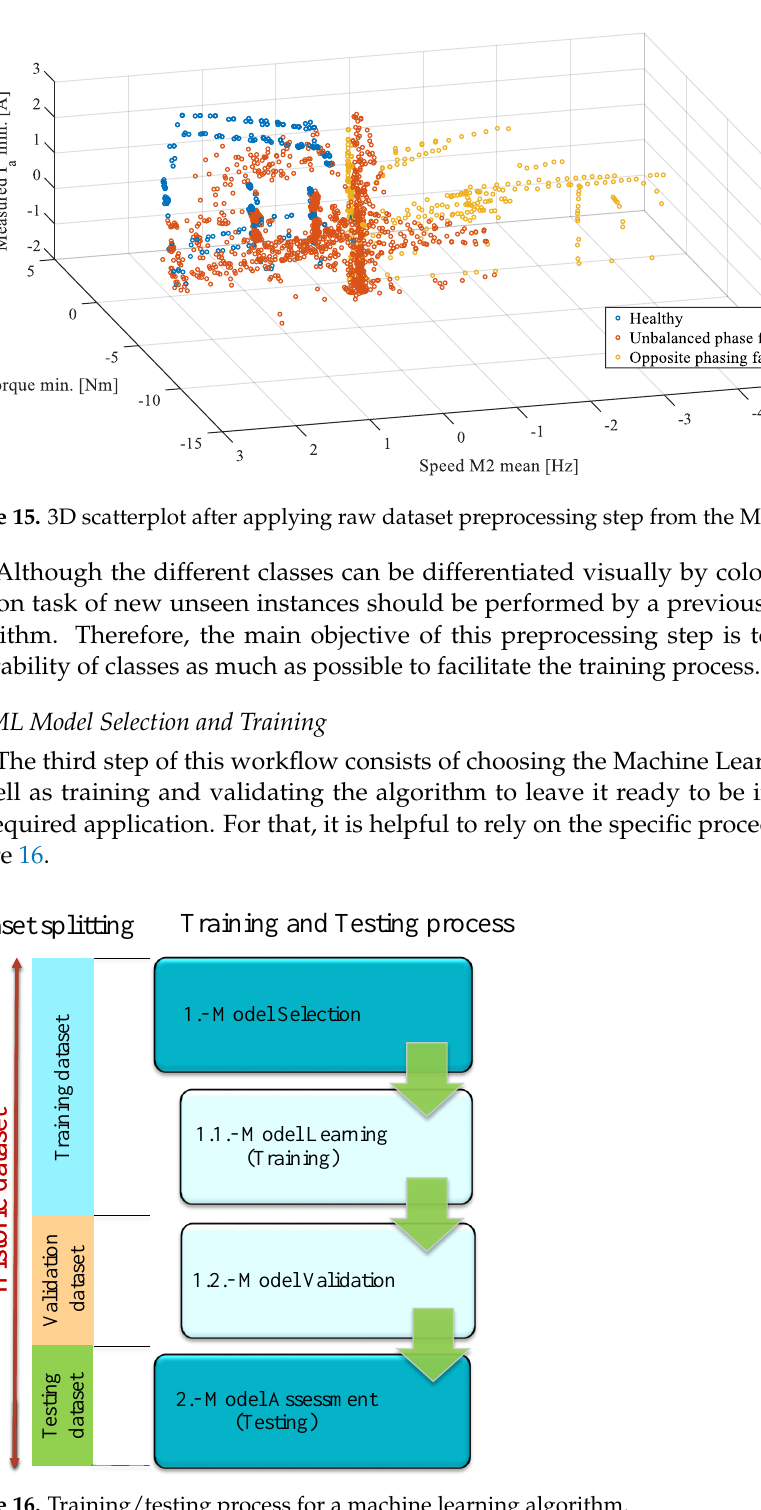
Figure 16. Training/testing process for a machine learning